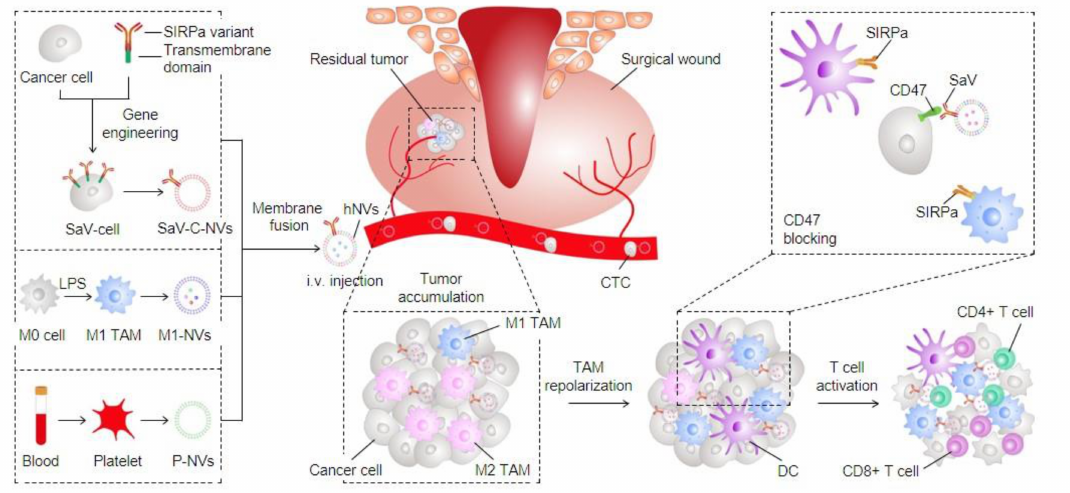
Figure 1. Schematic showing the formation of hNVs and the mechanism by which hNVs amplify macrophage immune responses against cancer recurrence and metastasis